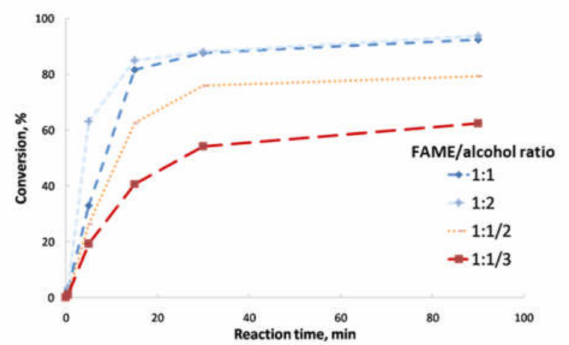
Figure 2. Effect of different FAME/alcohol ratios (1:1, 1:2; 1:1/2 and 1:1/3) on converScheme 100 ◦ C; catalyst concentration, 1%; stirring rate, 500 rpm; reaction time, 90 min).